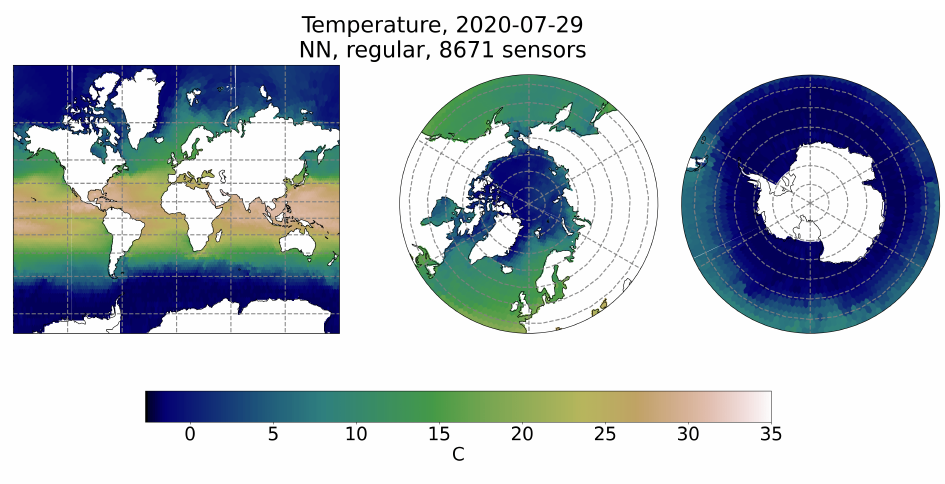
Figure A5. Reconstructed field by the Nearest Neighbor (NN) method from 8671 measurements with regular placement.